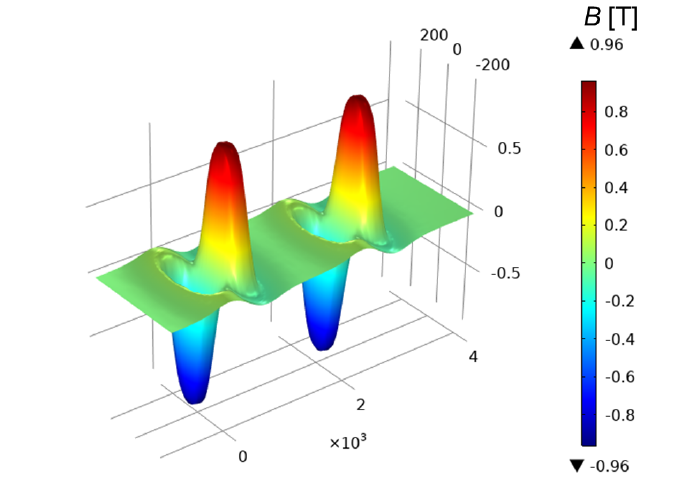
Figure 6. Axial B distribution on the figure-eight-shaped coils’